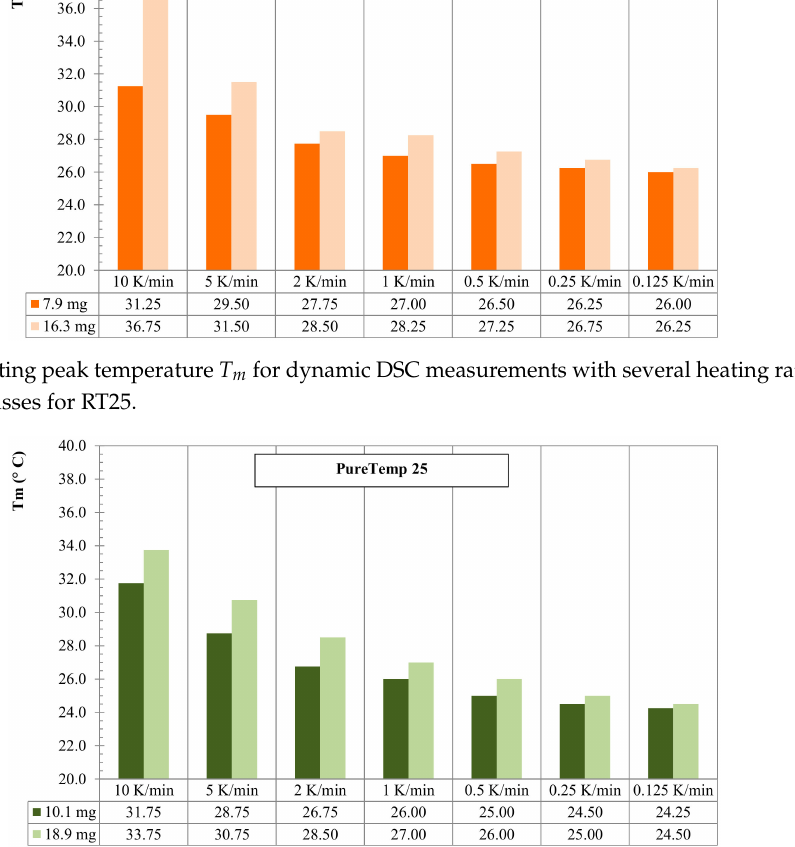
Figure 10. Melting peak temperature T m of dynamic DSC measurements with several heating rates and 2 di ff erent masses for